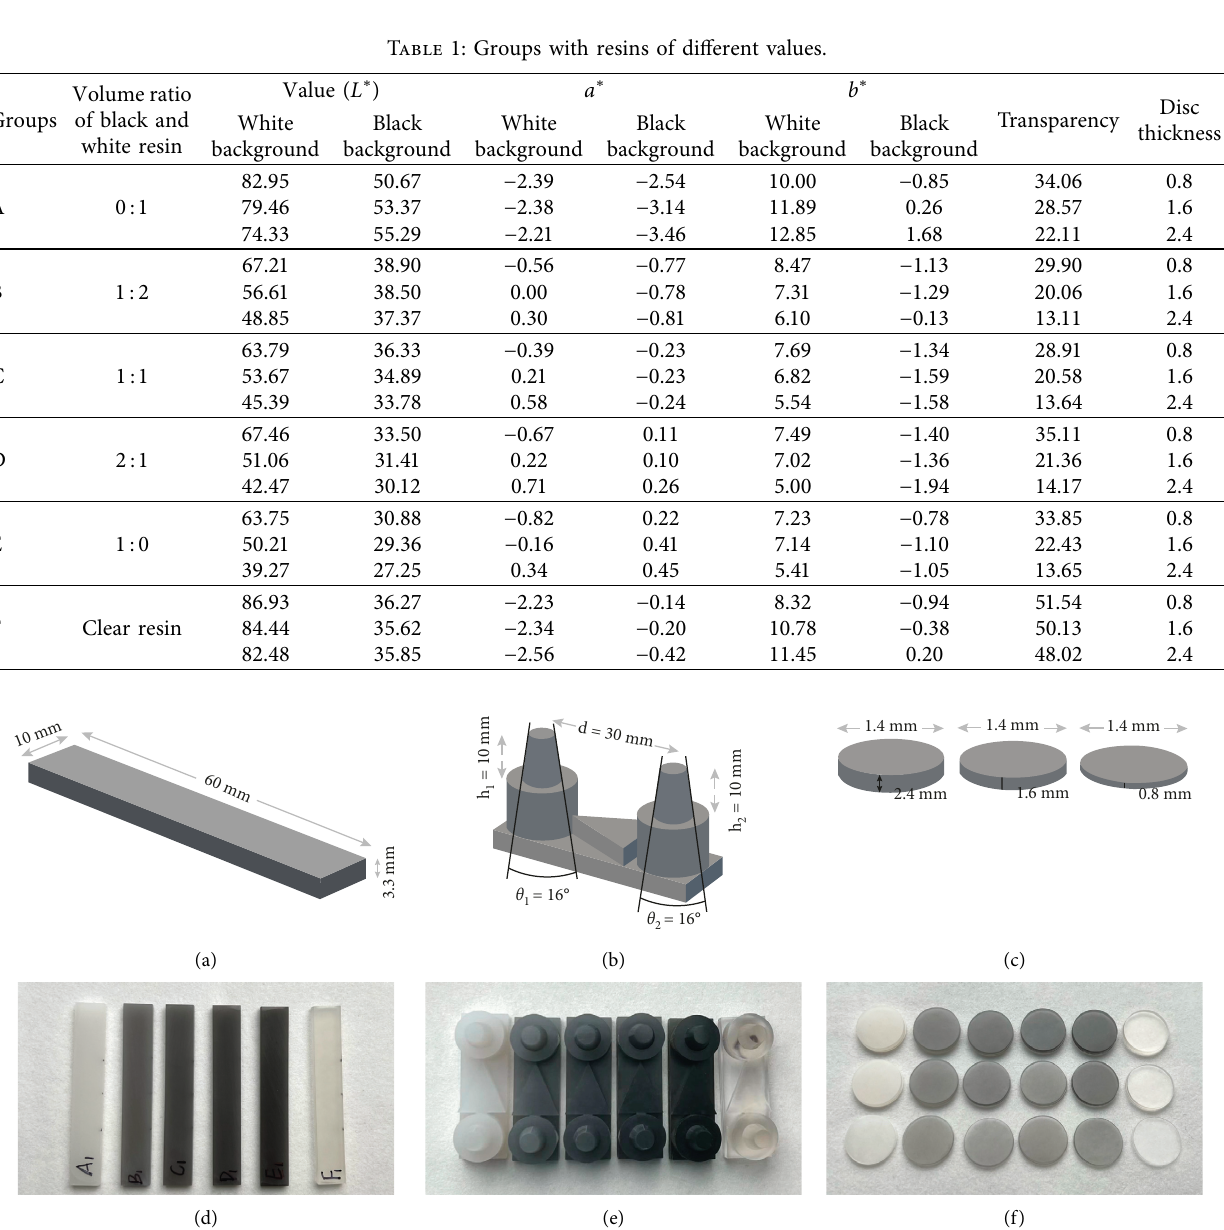
Figure 1: Schematics and actual photographs of plate model (a and d), crown-and bridge model (b and e), and disc model (c and f).